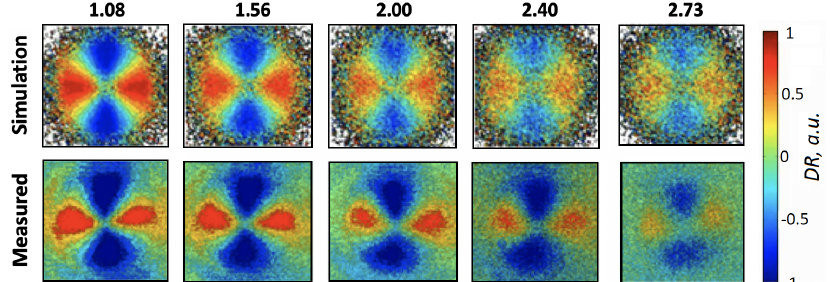
Figure 7. The results of experimental measurements of fringe contrast for CVB propagated through the turbid scattering media in comparison to the results of MC modeling performed for the turbid media with the same optical